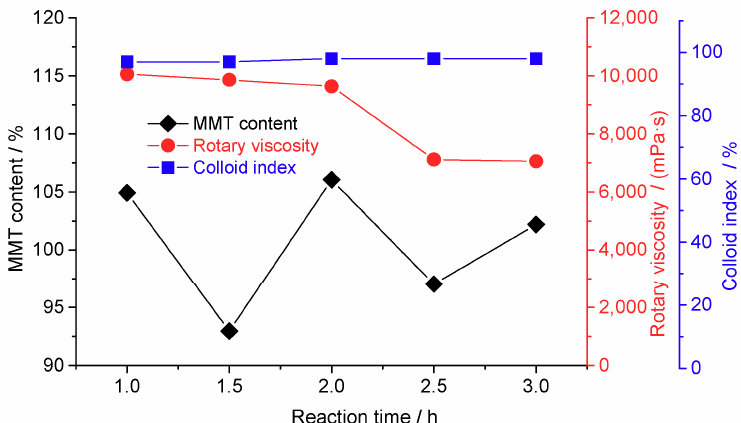
Figure 2. Properties of montmorillonite (MMT) as a function of the reaction time (reaction conditions: 25 °C, stirring speed = 300 rev/min, and sodium carbonate mass fraction = 2.8%).